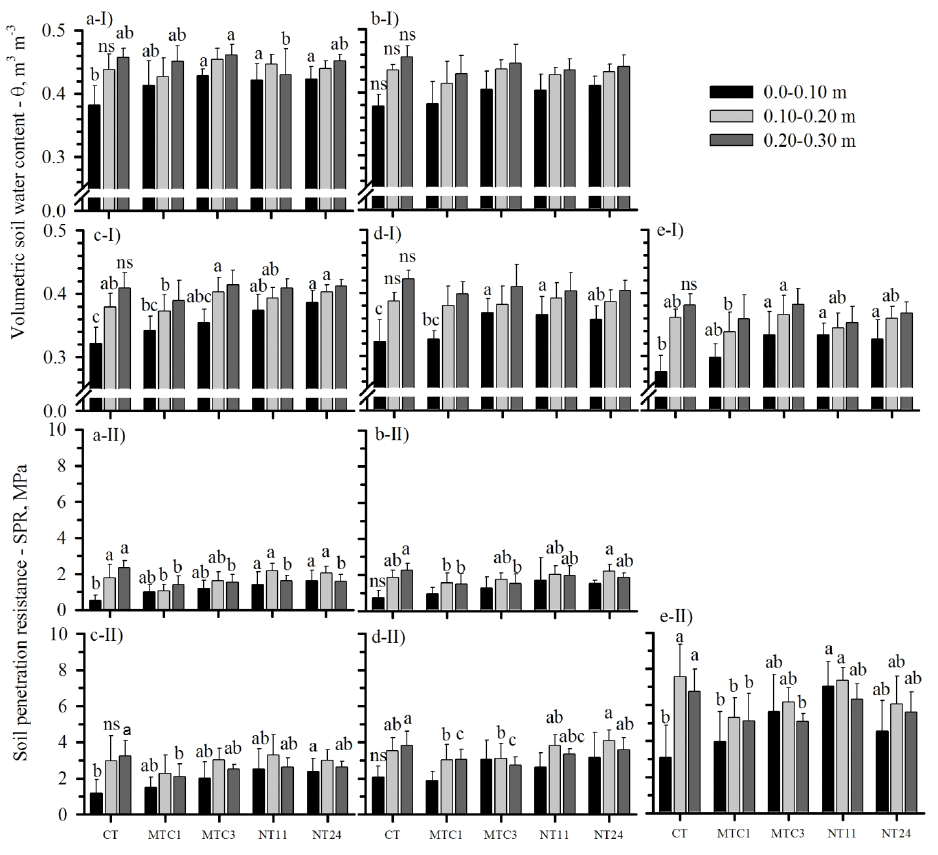
Figure 2. Volumetric soil water content (I) and soil penetration resistance (II) as a function of tillage systems, based on the matrix potential of -6 kPa (a), -10 kPa (b), -33 kPa (c) -100 kPa (d) and -500 kPa (e). ns Not significant by the F-test (p<0.05). Means followed by the same letter in the same layer do not differ by Tukey’s test (p<0.05). CT: conventional tillage system; MTC 1 : minimum tillage, annual chiseling; MTC 3 : minimum tillage, chiseled every three years; NT 11 : no-tillage for 11 years; NT 24 : no-tillage for 24 years. Vertical bars indicate the standard deviation from the mean